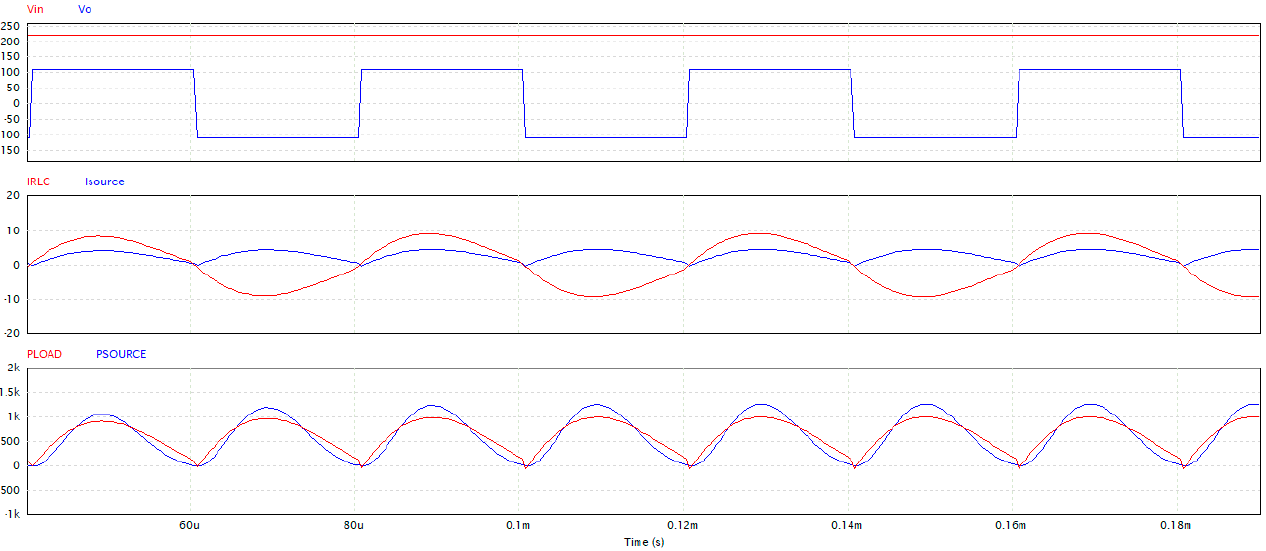
Energies 2021 , 14 , x FOR PEER REVIEW Figure 11. Switching waveforms for ferrous heating mode during simulation. Figure 11. Switching waveforms for ferrous heating mode during simulation.